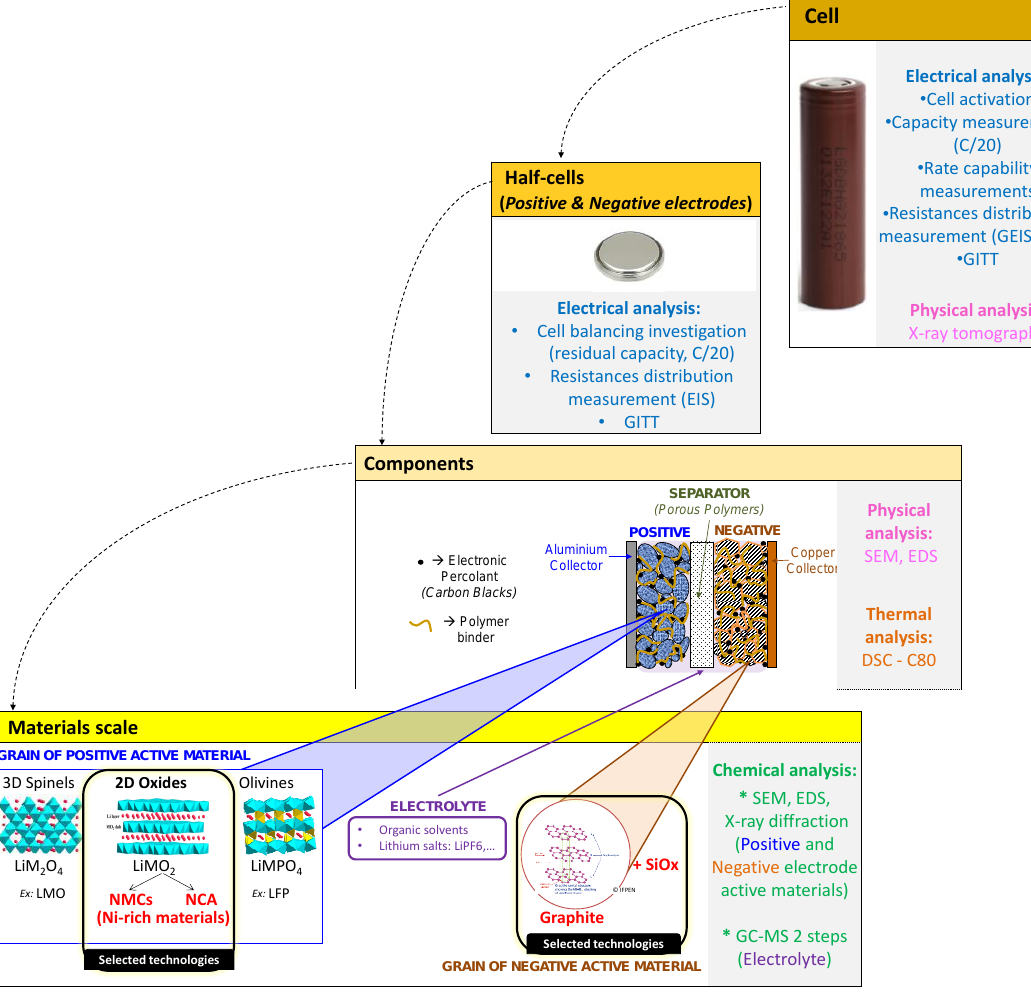
Figure 2. Process of the complete multiscale analysis of Lithium-ion battery